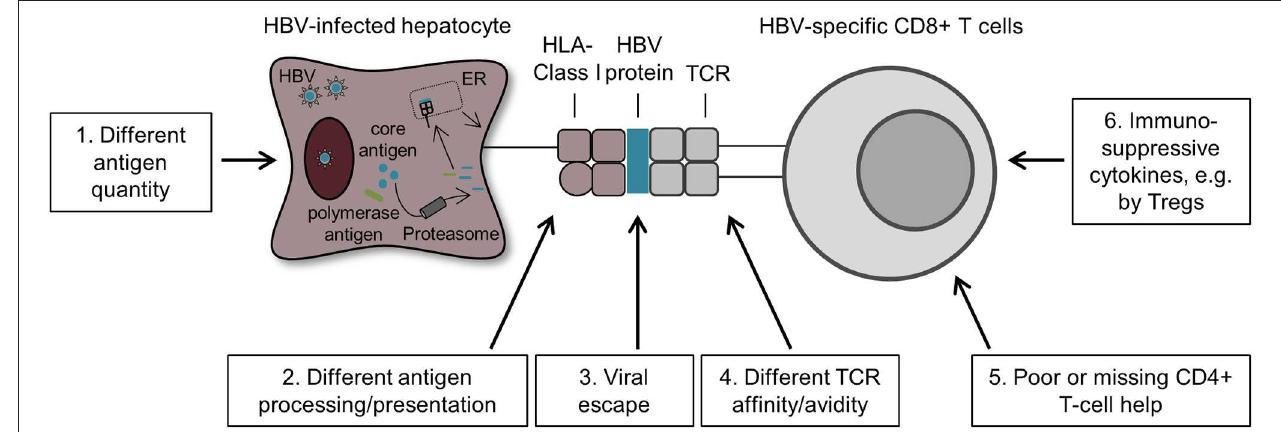
FIGURE 3 | Possible mechanisms that drive HBV-specific CD8 + T-cell heterogeneity. First, HBV-infected hepatocytes produced varying amounts of HBV antigens resulting in different quantities of HBV peptide/HLA complexes on these cells. This difference may modulate the heterogeneity of HBV-specific CD8 + T cells targeting different antigens (1). Second, HBV antigen processing and presentation may also impact the phenotype and function of core 18 - and pol 455 -specific CD8 + T cells. In fact, HBV core antigens are secreted in high quantities by HBV-infected hepatocytes and are therefore more likely cross-presented by antigen-presenting cells, whereas the low amount of HBV polymerase antigens are primarily presented by HBV-infected hepatocytes (2). Third, the phenomenon of viral escape also affects antigen recognition by HBV-specific CD8 + T cells and thus may also contribute to HBV-specific CD8 + T-cell heterogeneity (3). Moreover, several other factors are also likely to promote HBV-specific CD8 + T-cell heterogeneity such as TCR affinity/avidity (4), a poor or missing CD4 + T-cell help (5) and the presence of immunosuppressive cytokines produced by Tregs and DCs (6).